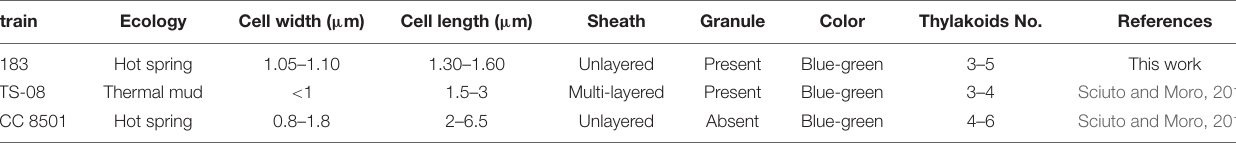
TABLE 1 | Morphological features of known Thermoleptolyngbya strains.